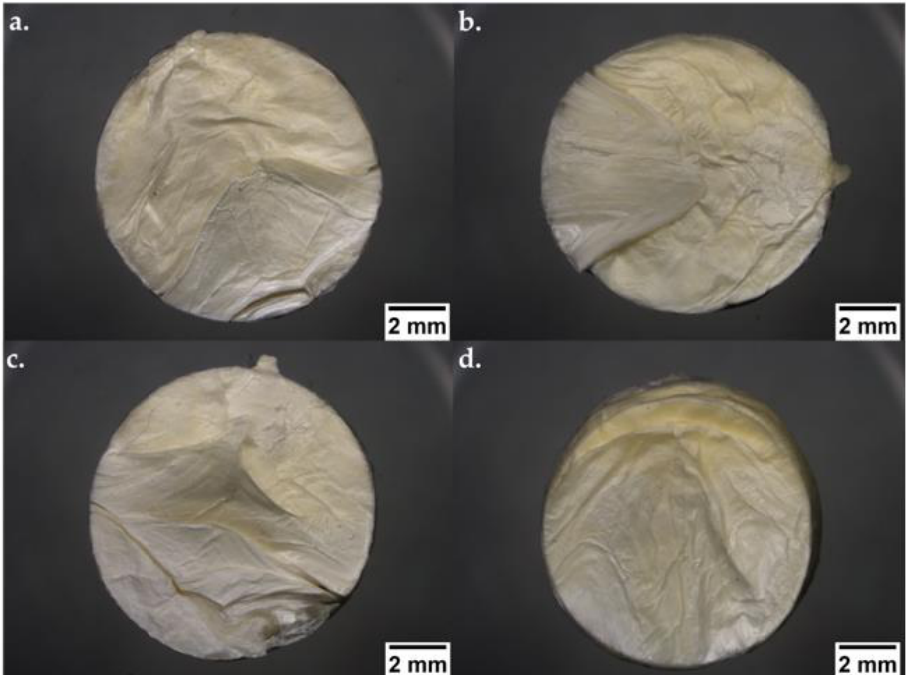
Figure 10. Digital photographs (ShuttlePix Digital Microscope, Nikon Corporation, Tokyo, Japan) of moulded tablets based on PEO and PCL blends after exposure to the dissolution medium at pH 2: ( a ) SDF 2 and ( c ) SDF 3, and pH 5.5: ( b ) SDF 2 and ( d ) SDF 3.